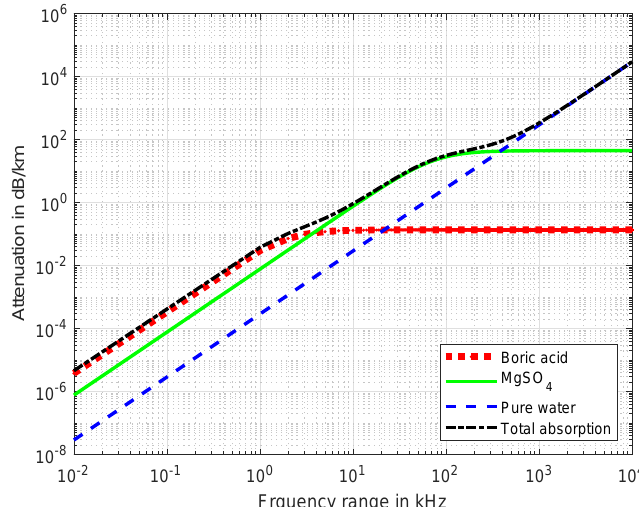
Figure 6. Transmission lobes in environments with water and other real